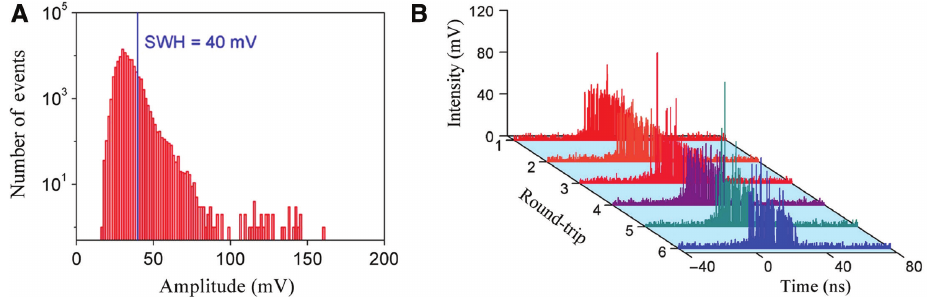
Figure 12: Rogue waves generated in a fiber laser with a TI-deposited microfiber SA. (A) Evolution of a chaotic multi-pulse bunch over several cavity round trips. (B) Intensity histogram on the log scale of the chaotic multi- pulse bunch. Reproduced with permission [185]. Copyright 2015, The Optical